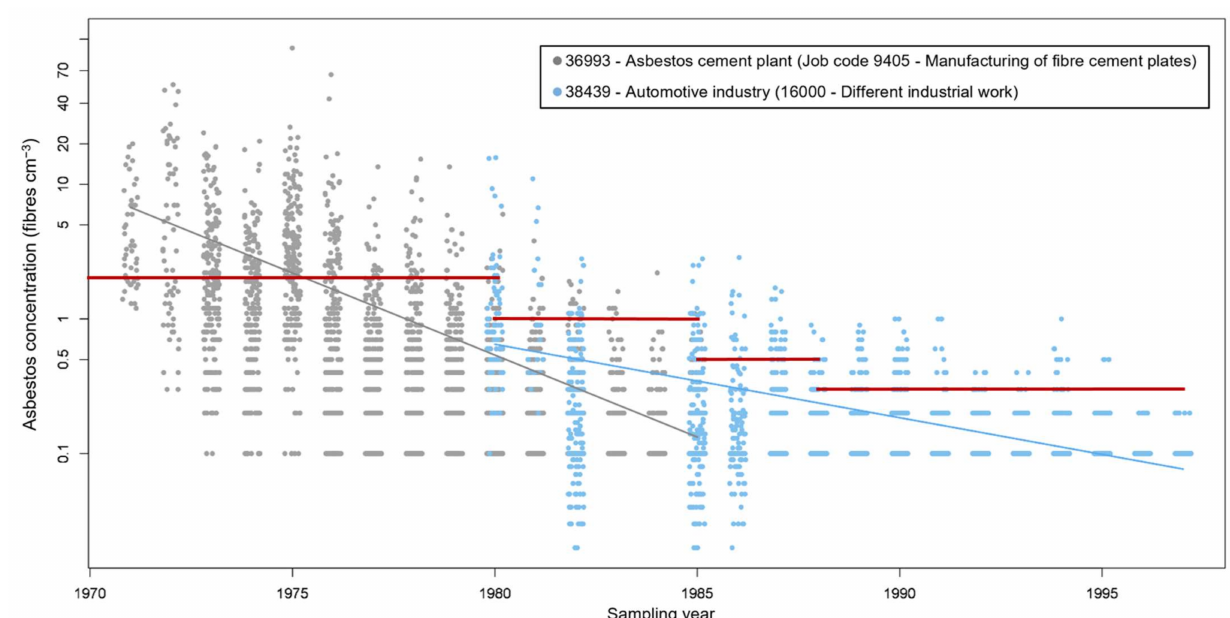
Figure 3. Personal exposure asbestos exposure concentrations against sampled year. The grey and blue lines stand for the log-linear gamma model fit applied for industry sector 36993 and 38439, respectively. All the personal measurements at the asbestos cement plant correspond to exposures without use of RPE, while at the automotive industry it is unknown if RPE was used. Horizontal red lines show the different health guideline values over time. (For interpretation of the references to colour in this figure legend, the reader is referred to the web version of this